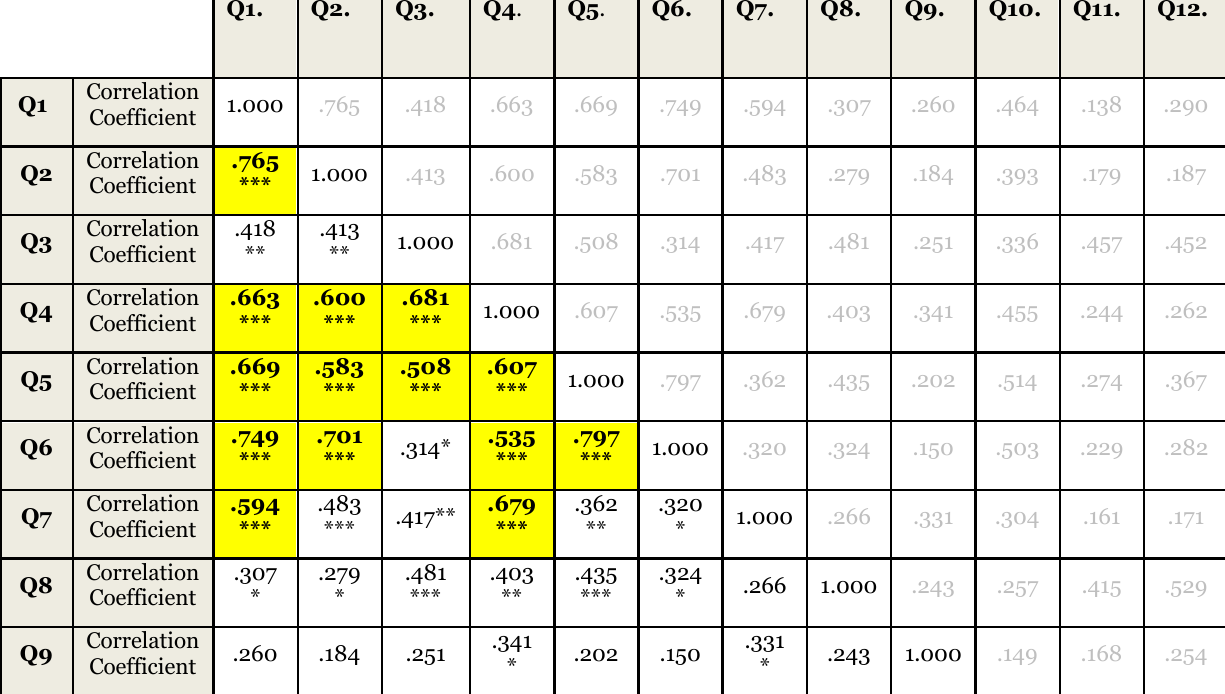
Correlation between the Survey